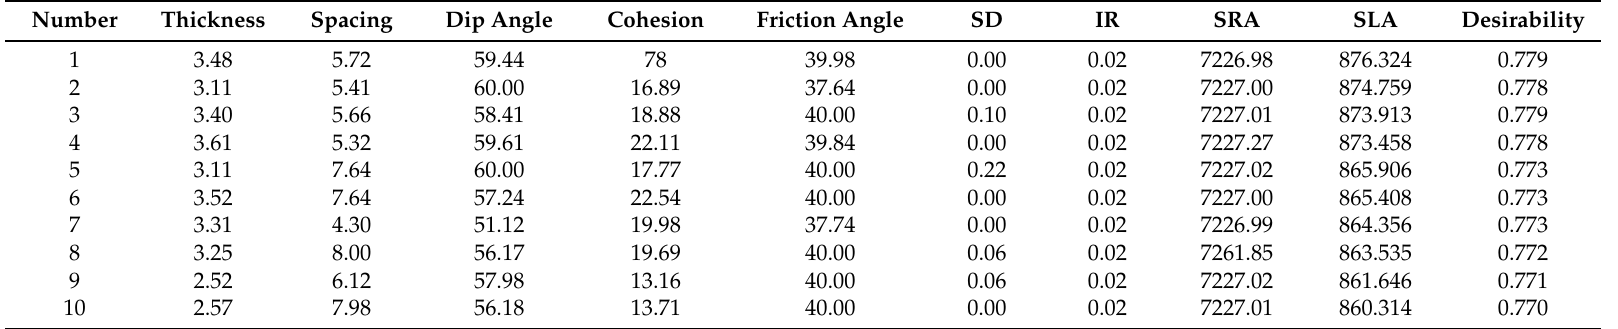
Table 6. Optimal combinations and optimization